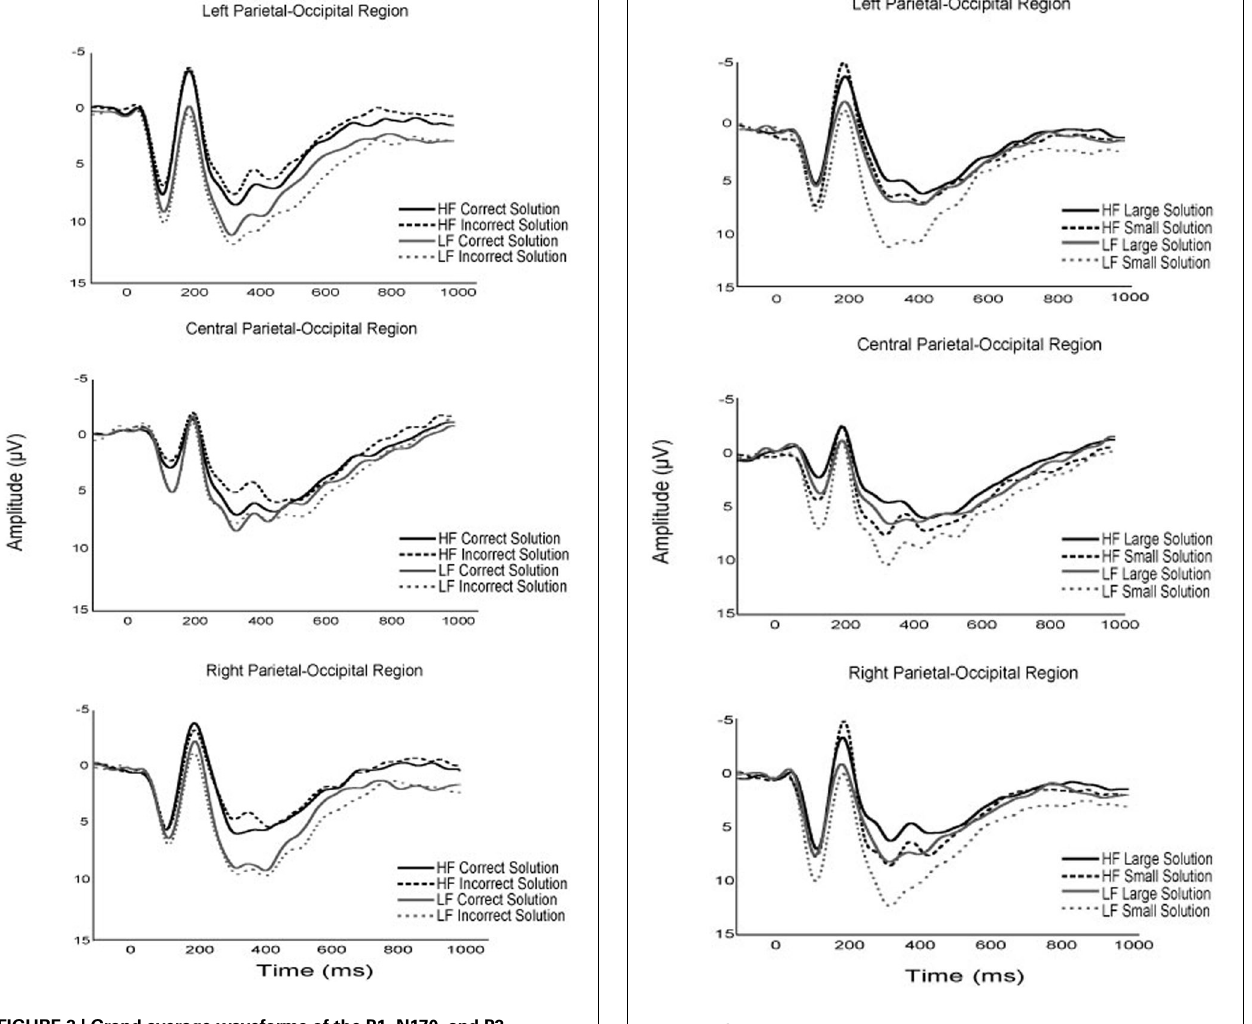
FIGURE 4 | Grand average waveforms of the P1, N170 and P3 components for higher and lower fit participants, for large and small experimental task